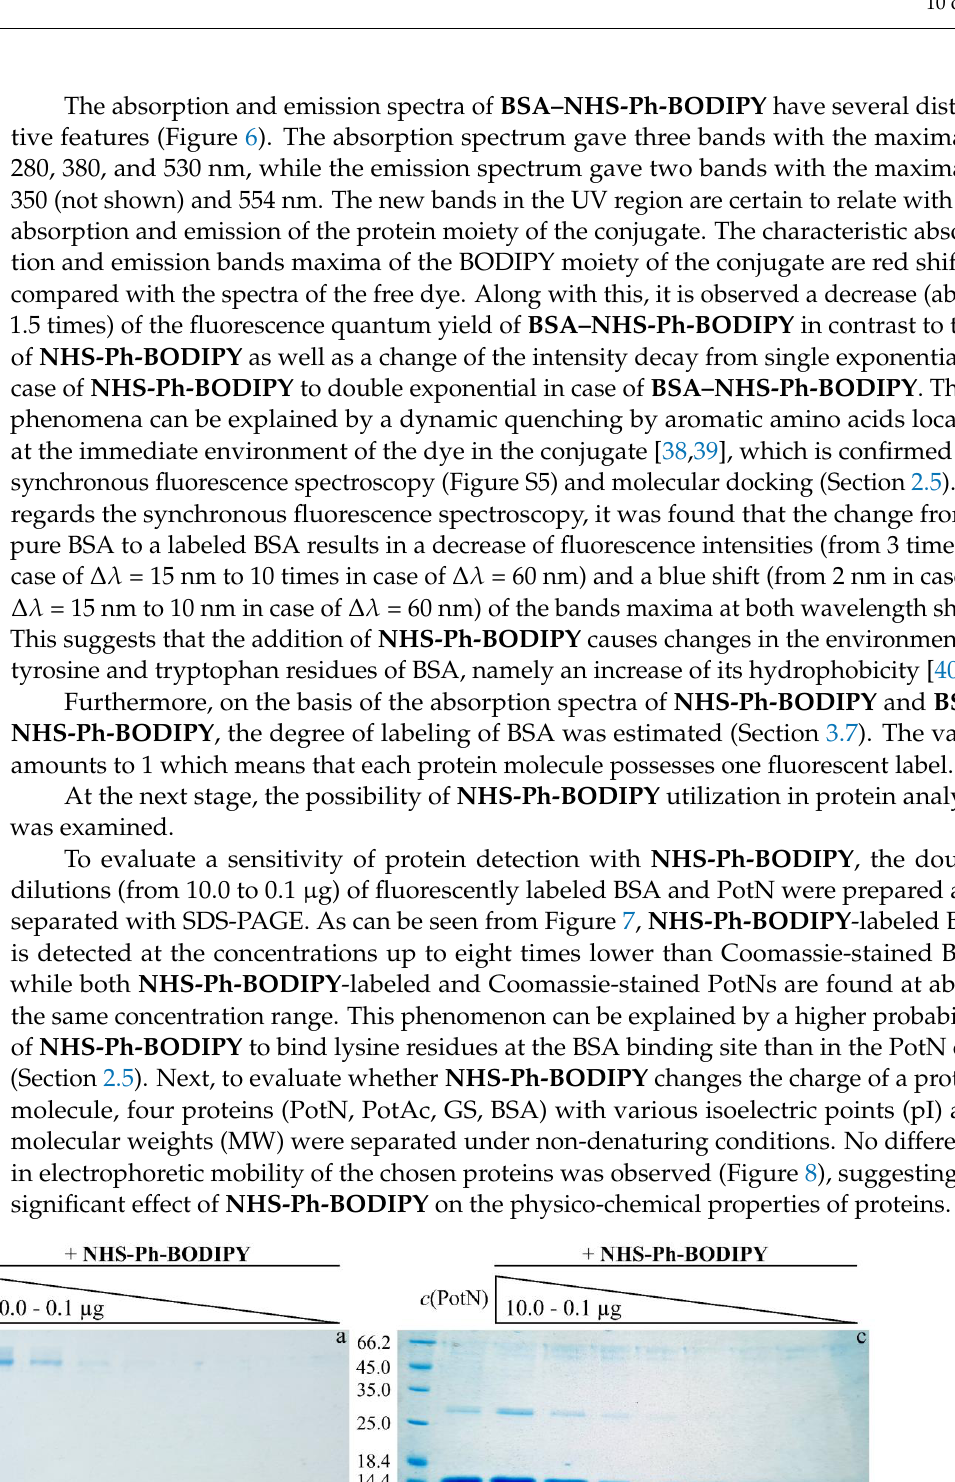
Figure 8. Basic native-PAGE of NHS-Ph-BODIPY -labeled (+ Flu) and unlabeled PotN (MW = 13.7 kDa, pI = 6.6), PotAc (MW = 18.1 kDa, pI = 5.9), GS (MW = 50.3 kDa, pI = 5.1), and BSA (MW = 66.2 kDa, pI = 5.9) visualized with Coomassie brilliant blue ( a ) and using UV transillumination ( b ) (each lane contains 10 µg of protein). 2.5. Molecular Docking of Protein – BODIPY Conjugates To gain insight into protein – BODIPY interactions, a two-stage molecular docking of BSA and PotN with NHS-Ph-BODIPY was carried out. At the first stage, a blind docking was performed to determine the most probable binding site of NHS-Ph-BODIPY in BSA. It was shown that the fluorescent dye is local- ized in a cavity between the IB, IIA, and IIB subdomains of the protein (Figure 9a) with a binding free energy of −2 6.1 kJ/mol. It is noteworthy that these subdomains are known to contain major drug binding sites [41 – 43]. The amino acid composition of the binding site of NHS-Ph-BODIPY in BSA is shown in Figure 9b. The binding site was found to contain three lysine residues (Lys187, Lys221, Lys294), each of which was selected for a subsequent covalent docking. In addition, it contains tyrosine (Tyr149, Tyr156, Tyr451)